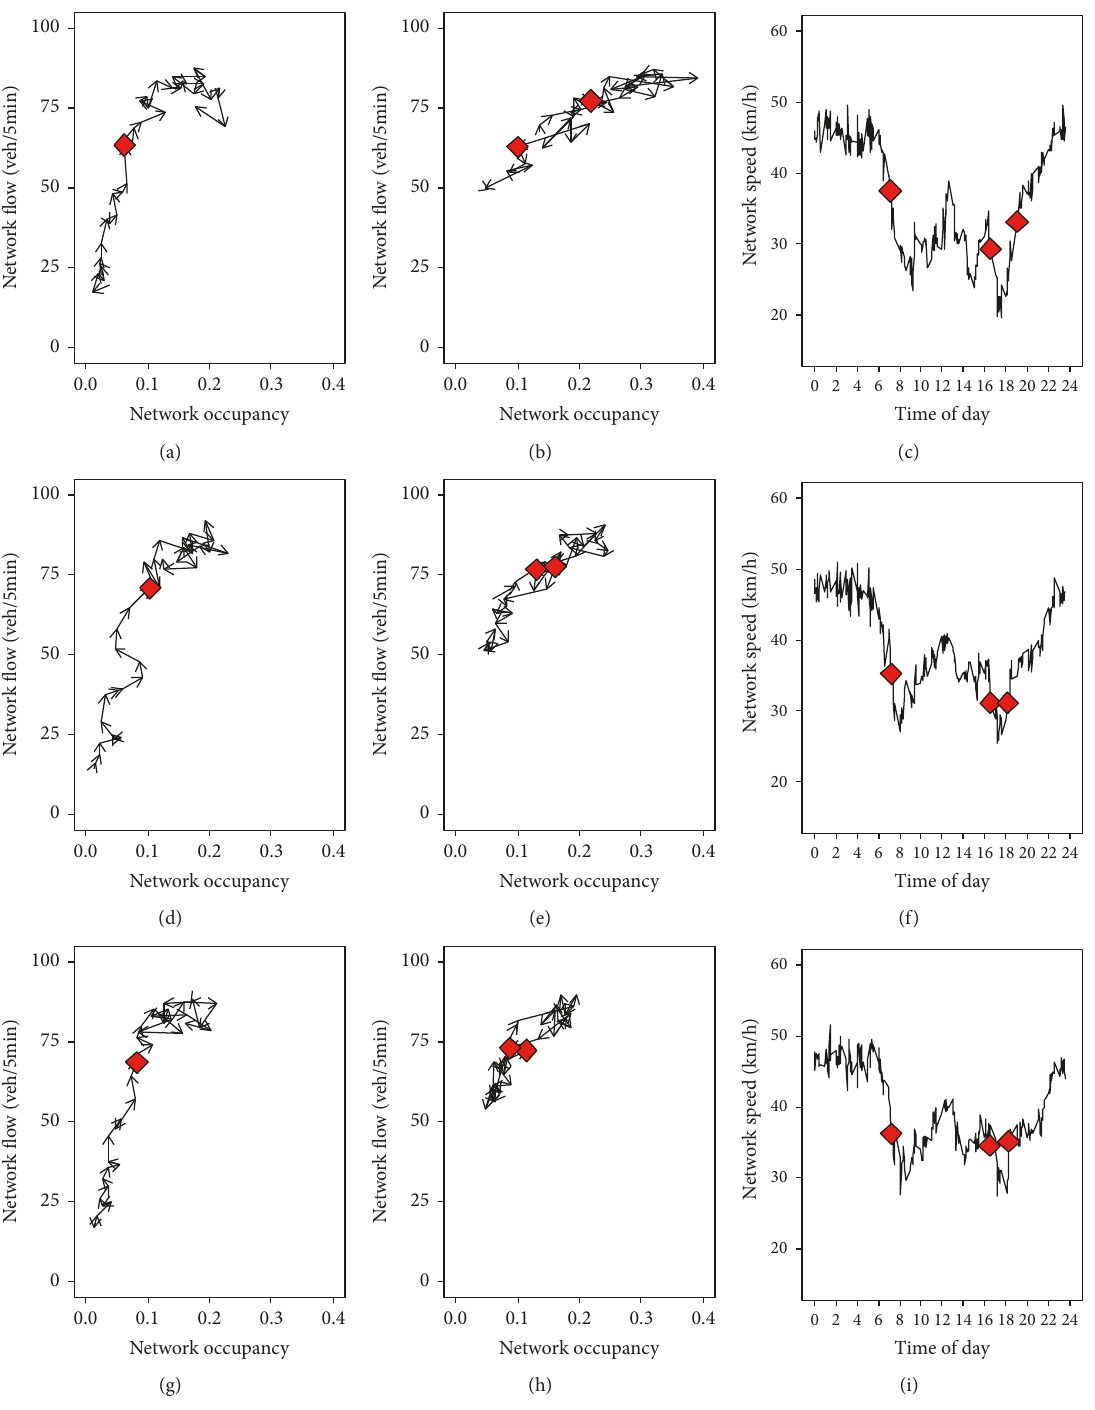
Figure 6: The validation of the identified CTS points on August 10, Monday, 2015, and August 12, Wednesday, 2015. (a), (d), and (g) The CTS points during morning peaks of the three days. (b), (e), and ( h) The CTS points during afternoon peaks of the three days. (c), (f), and (i) Correlation between the CTS points and network